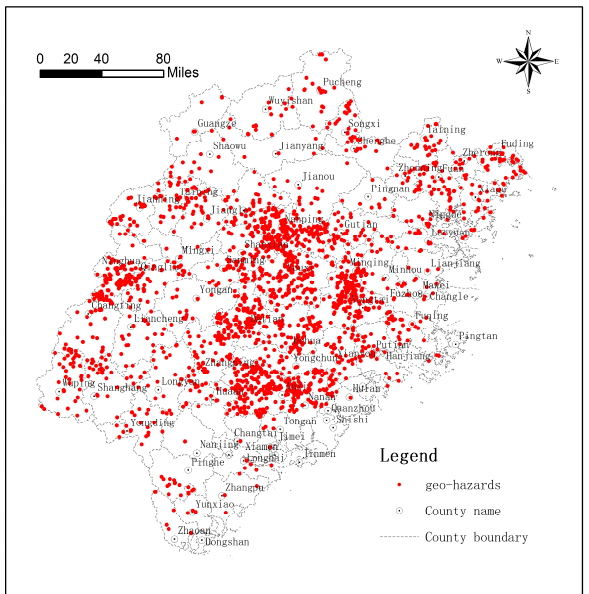
Figure 1. Distribution map of geological disaster points in Fujian Province.